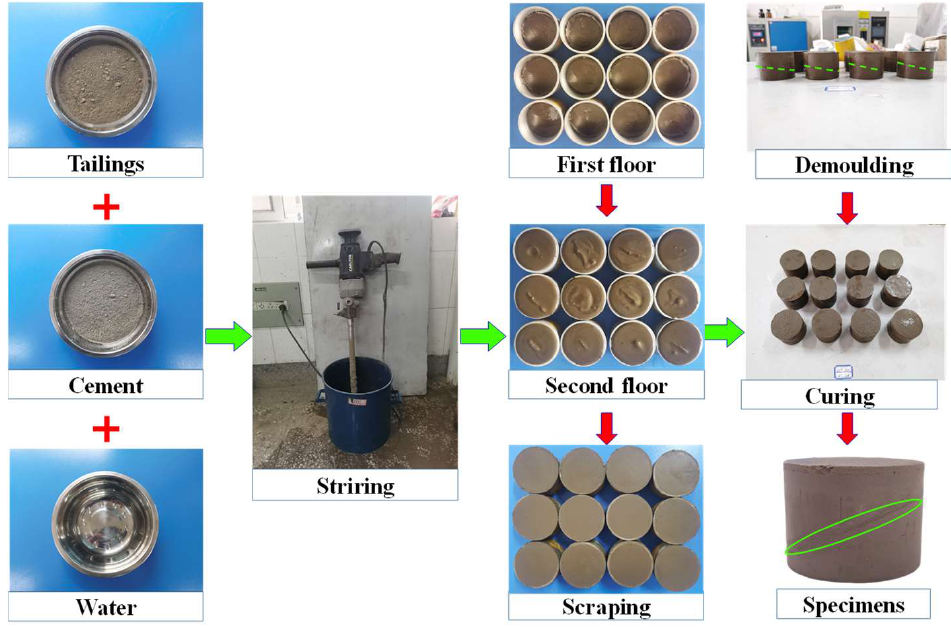
Figure 2. Specimen preparation flow chart.